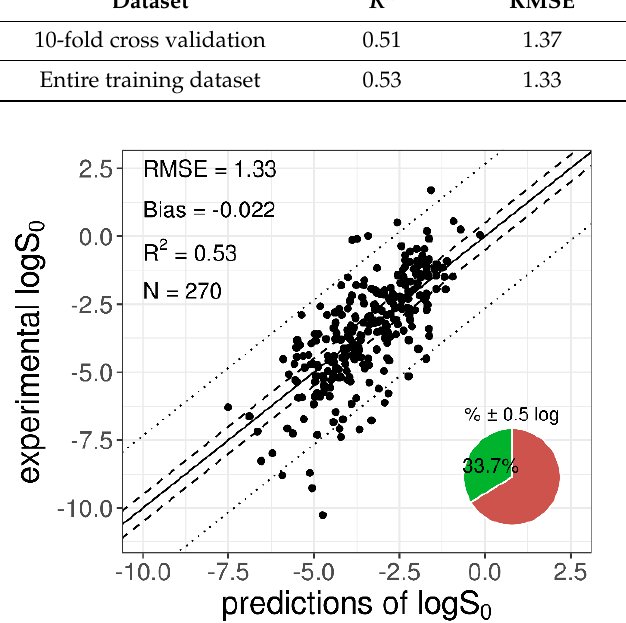
Table 3. Statistical MPPs obtained with the 10-fold cross validation and the entire training dataset.